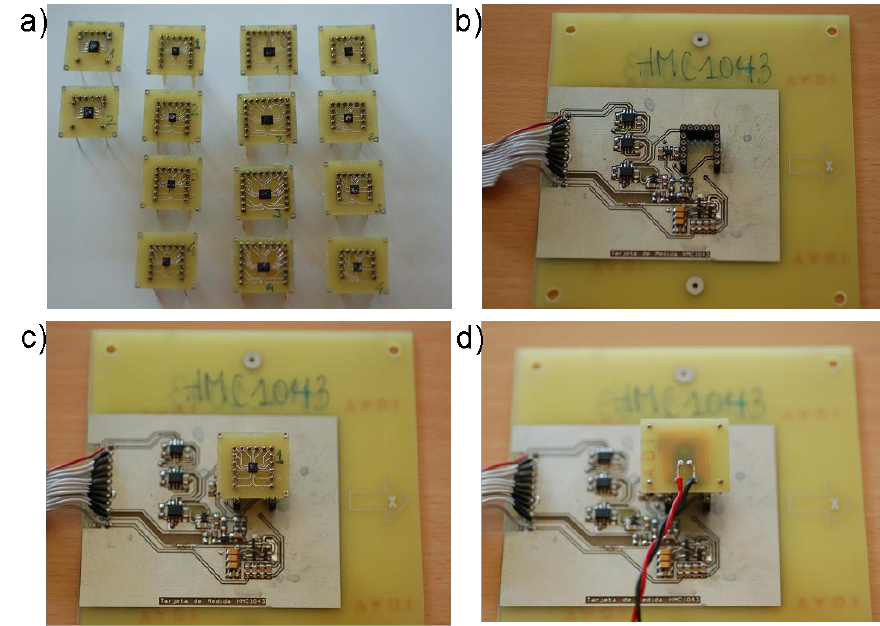
Figure 2. ( a ) From left to right in columns: sensors HMC 1021 S, HMC 1043, HMC 6042, HMC 6052 soldered to PCBs; ( b ) Test board of the HMC 1043 sensor; ( c ) Sensor HMC 1043, number 1, plugged to the test board; and ( d ) HMC 1043 and PT-1000 plugged to the test board.